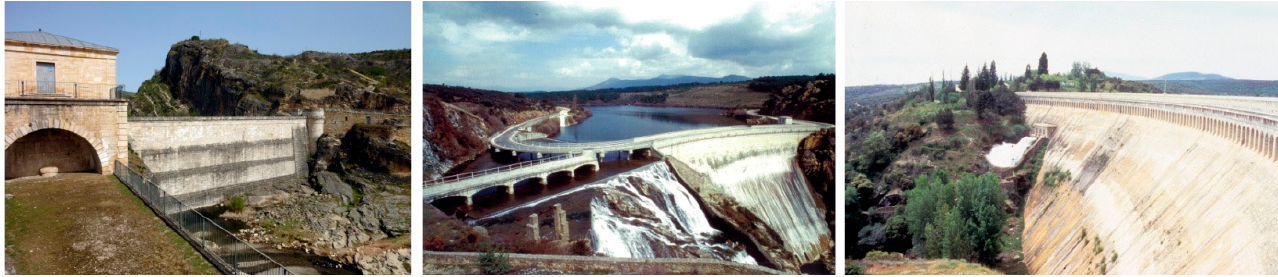
Figure 8. Siphons: Guadalix Siphon; Morenillo Siphon. Source: Clifford, 1858; FMA. Table 2. Main siphons in Europe. Note the maximum load of those designed in Madrid, exceeded only by the ones in Liverpool [2]. Population Siphon